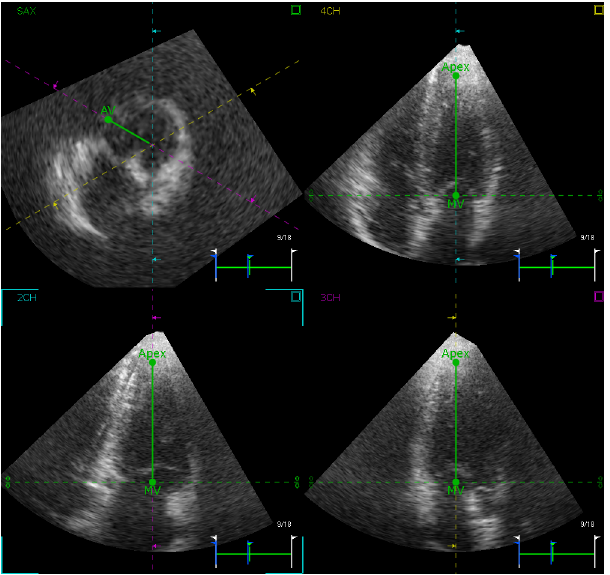
Fig 1. Three-dimensional speckle-tracking echocardiography (3D STE) offline analysis. First, the long axis (LAX) view is selected. The mitral valve landmark is placed at the annular level in the middle of the mitral valve, and the apical landmark is placed at the apex. Then, the short-axis view is selected. The aortic valve landmark is placed at valve level in the middle of the aortic valve. Manual tracking revision is performed if needed.